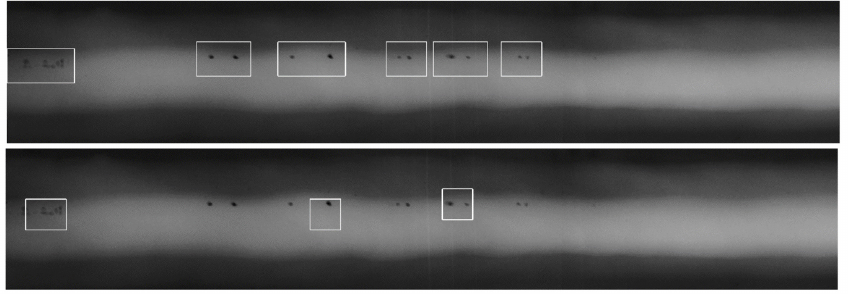
Figure 15. The comparison of the proposed approach with different patch sizes 120 ( top ) and 180 ( bottom ) based on Image 2 of GDXray dataset